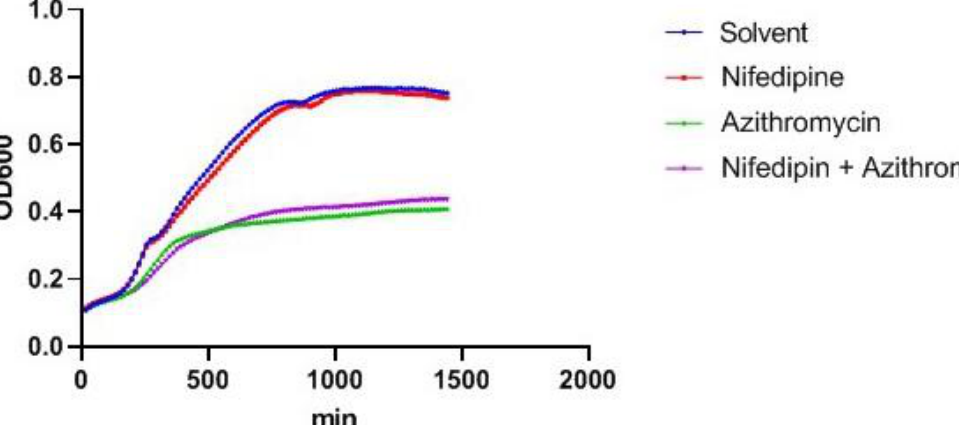
Figure 3. Bacterial proliferation assay. Bacterial cultures with Salmonella Typhimurium in DMEM medium were incubated with solvent control, 17.3 µ g/mL nifedipine, 0.3 µ g/mL azithromycin or a combination for the indicated time period. Bacterial proliferation was measured photometrically by OD600 every 15 min. One representative experiment of three is shown.